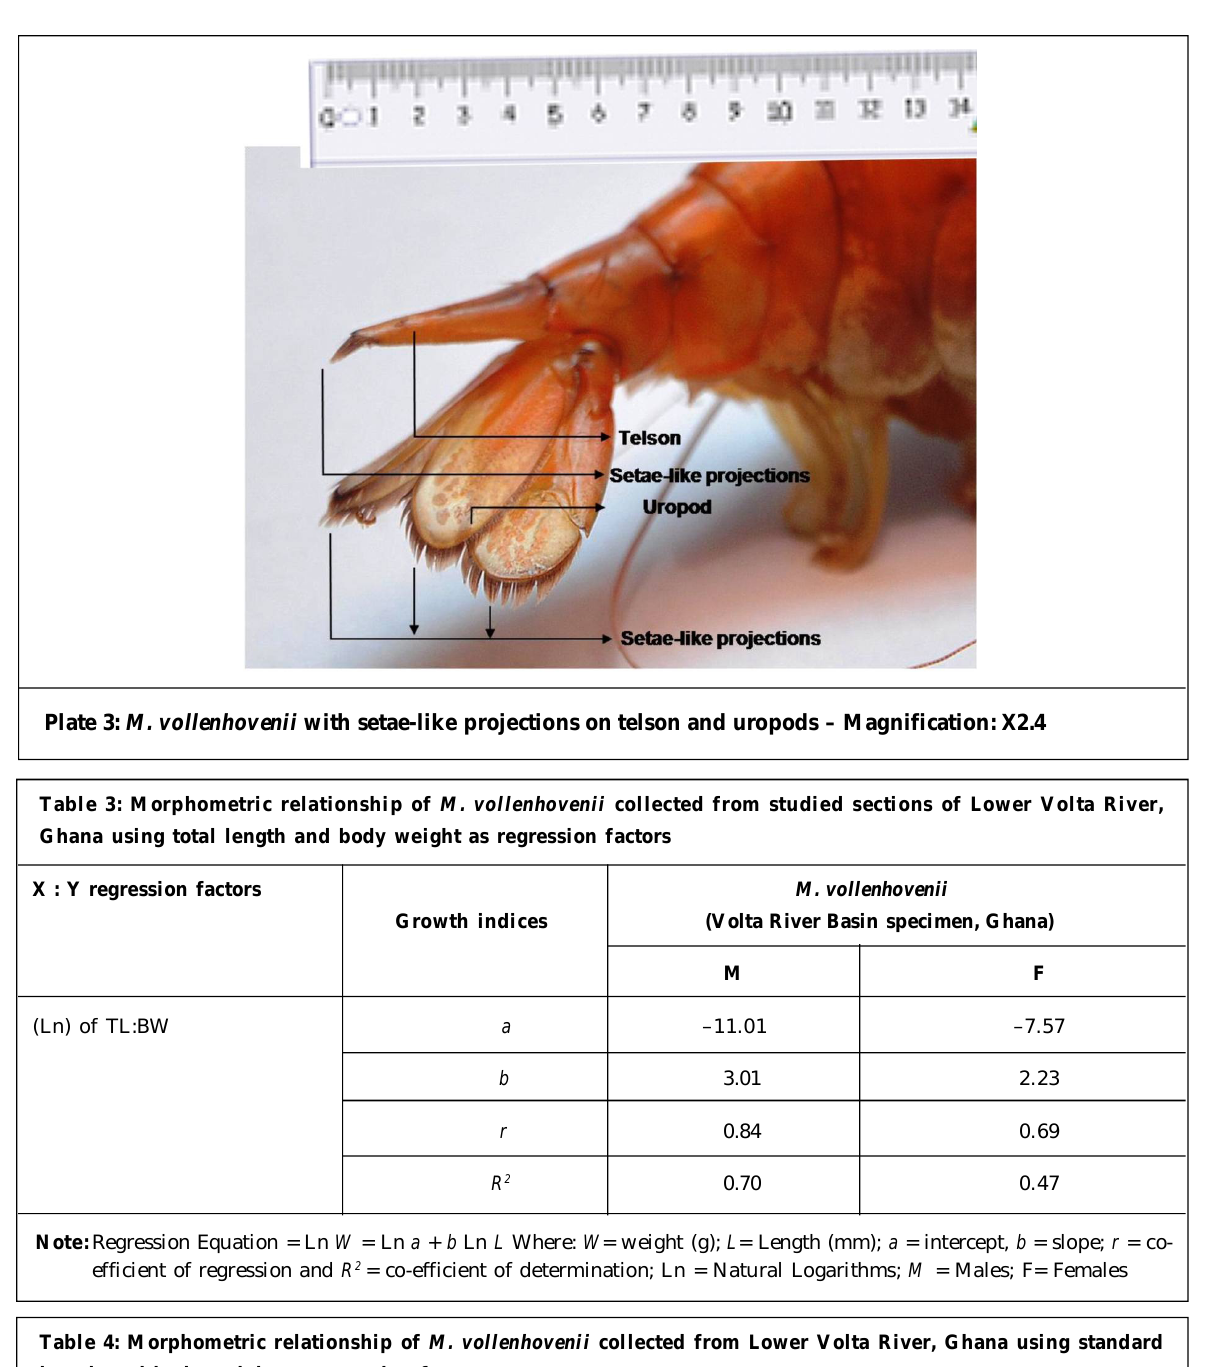
Table 4: Morphometric relationship of M. vollenhovenii collected from Lower Volta River, Ghana using standard length and body weight as regression factors X : Y regression